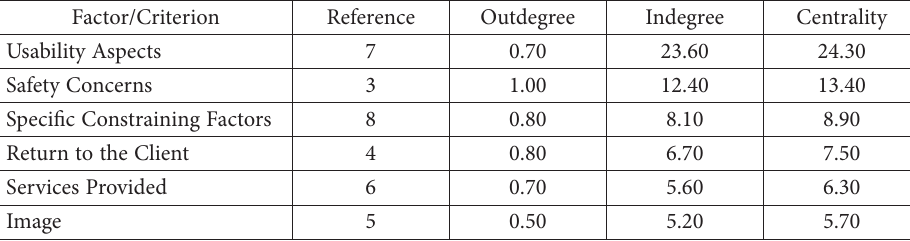
Table 3. Degree of centrality of customer’s preference